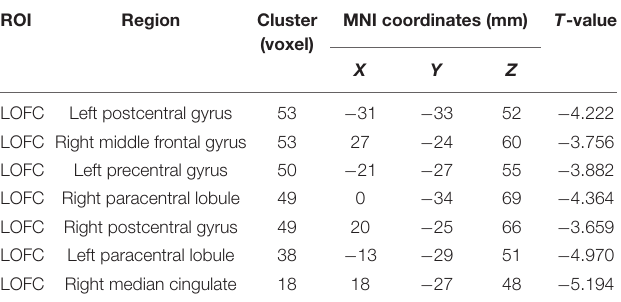
TABLE 3 | Coordinates the peaks of the brain regions with decreased rsFC in naïve schizophrenic patients. ROI